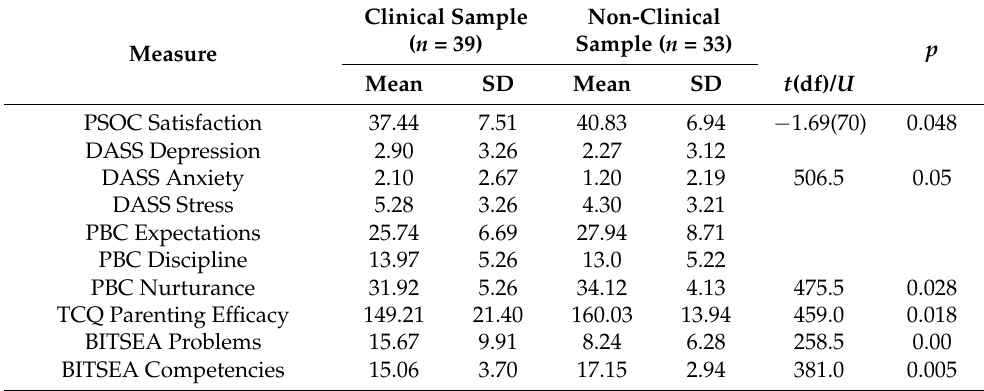
Table 1. Overview of Questionnaire